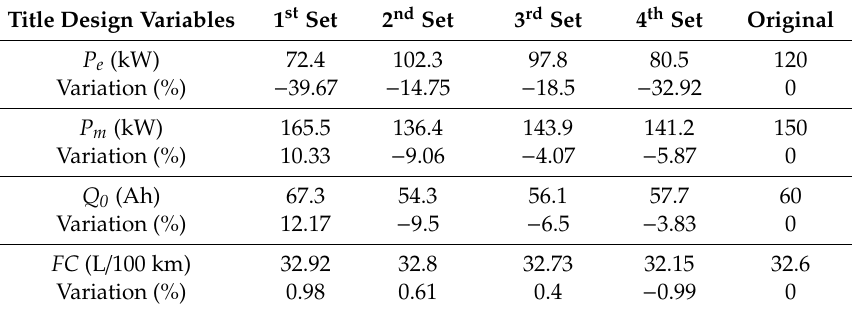
Table 4. Optimal matching results using weight method.